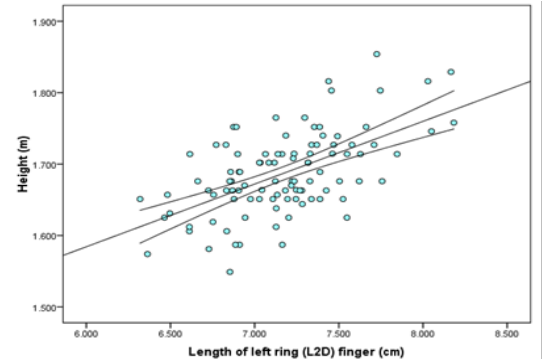
Fig 4. Correlation of length of left index finger with height